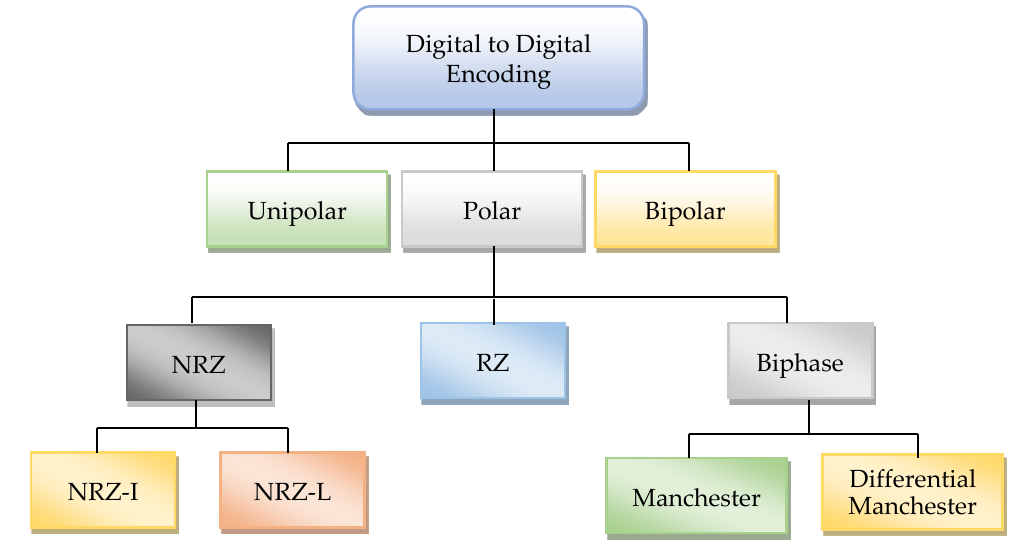
Figure 1. Digital encoding techniques.